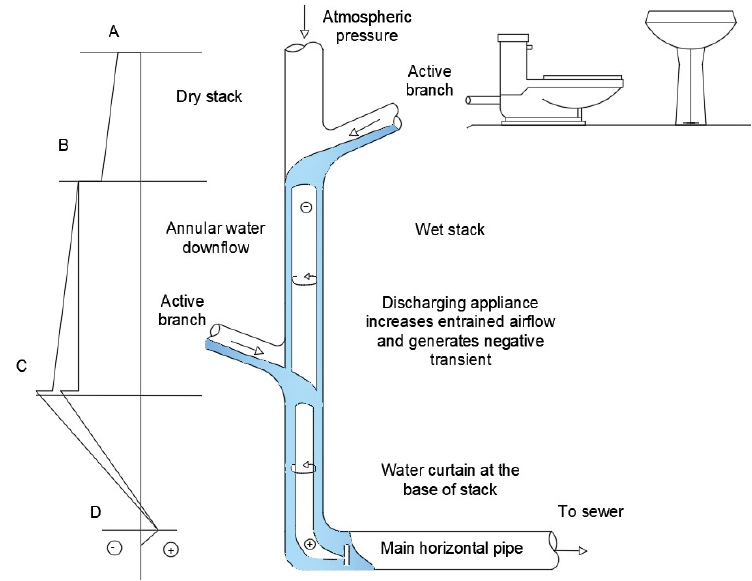
Figure 2. Single stack drainage profile with two active branches .